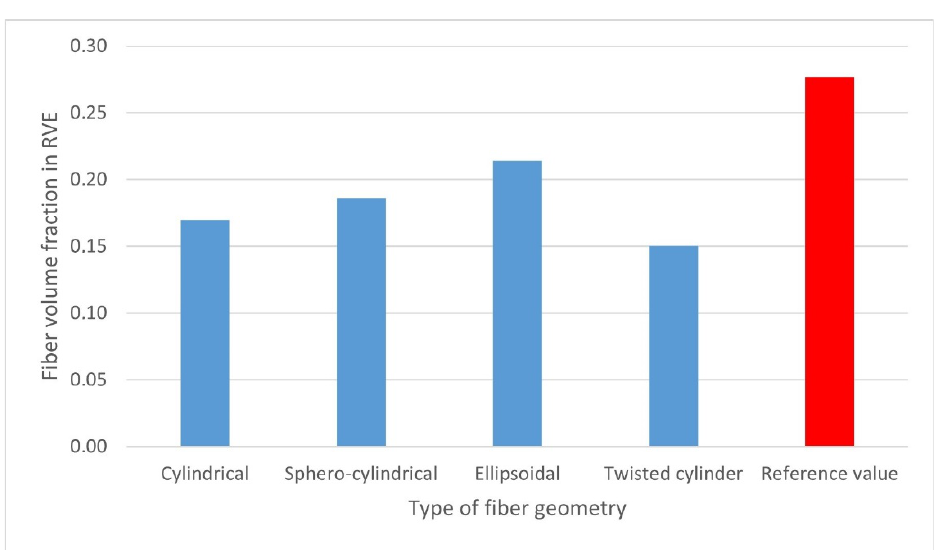
Figure 8. Calculated fiber volume content of the analyzed RVE in relation to the reference value of 27.7% for different types of fiber geometry.